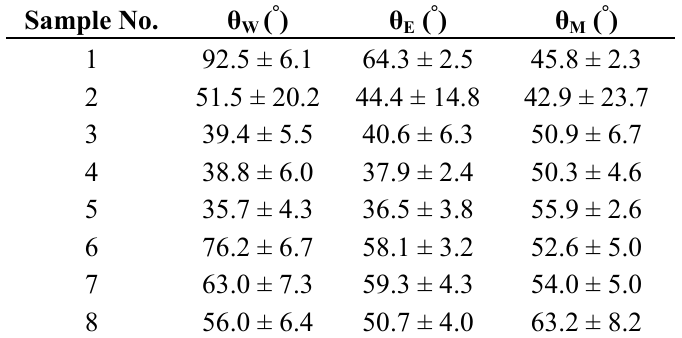
Table 1. Contact angle (θ) analysis results of untreated and modified substrates using deionized water (W), ethylene glycol (E), and methylene iodide (M) as wetting agents (contact angle data precision is indicated by standard deviation preceded by mean